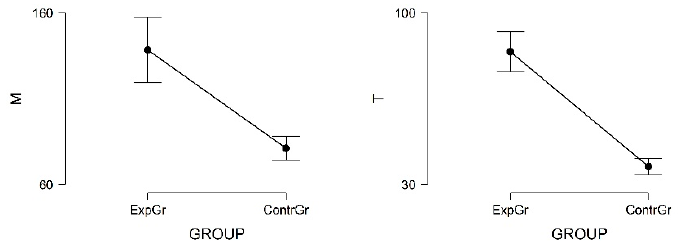
Figure 11. Descriptive plot showing significant differences between both groups regarding the number of messages sent (M) and turns (T).